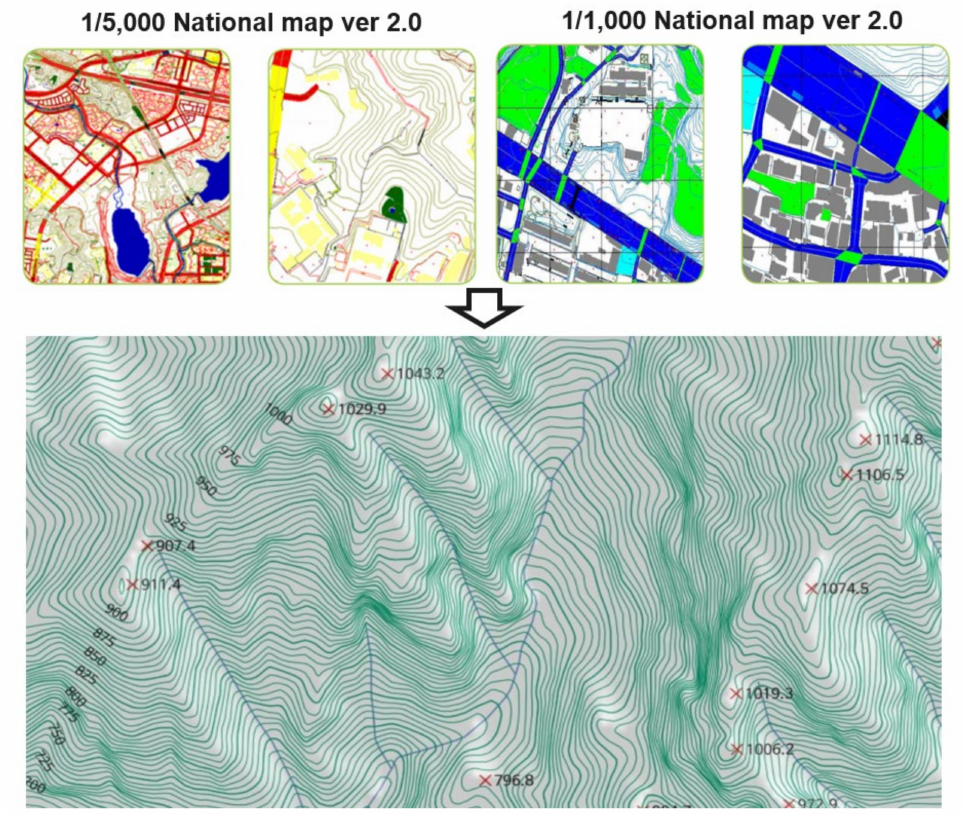
Figure 2. Digital elevation model extracted from 1/5000 and 1/1000 national map ver